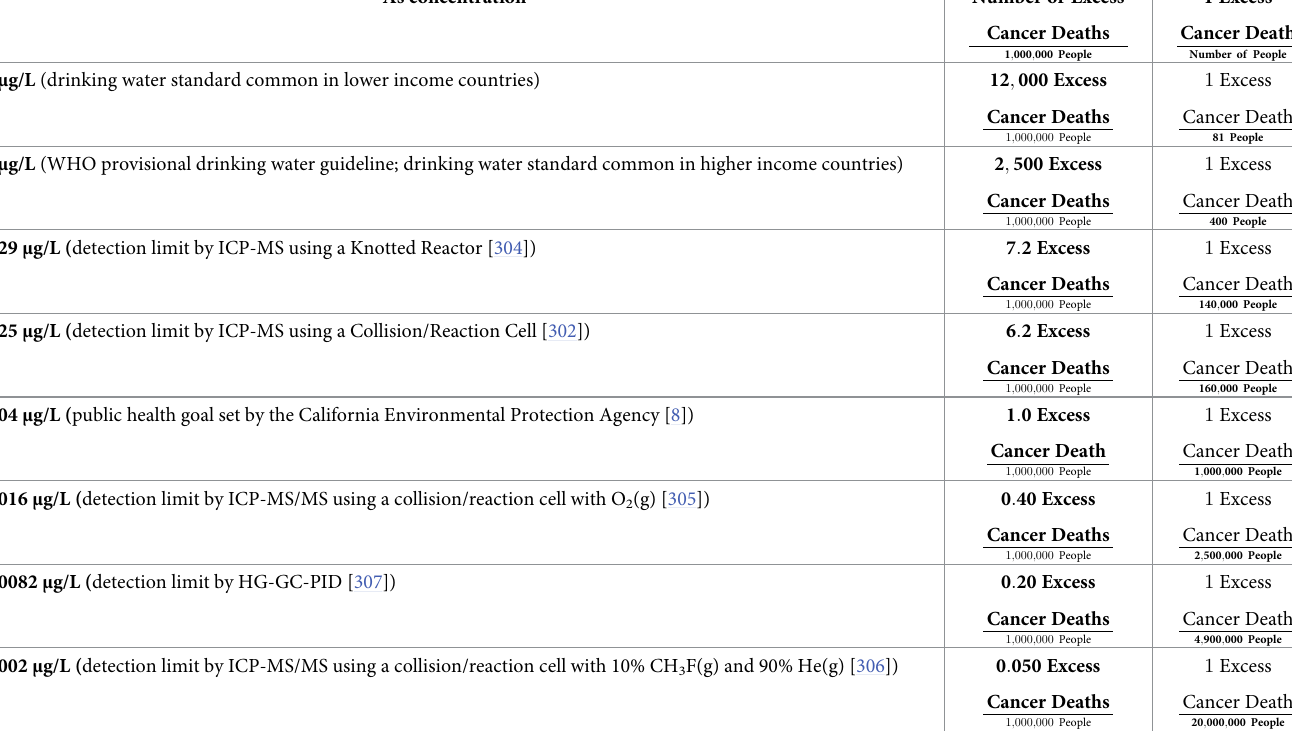
Table 4. Common drinking water standards, guidelines, and public health goals for total arsenic (As) in micrograms per liter ( μ g/L), the detection limits for total As in μ g/L by inductively coupled plasma-mass spectrometry (ICP-MS), inductively coupled plasma-tandem mass spectrometry (ICP-MS/MS), and hydride genera- tion-gas chromatography-photoionization detection (HG-GC-PID), and the estimated cancer risks at these concentrations (Eqs 1, 2, 3, 4, 5 and 6). These cancer risks are in bold font and rounded to 2